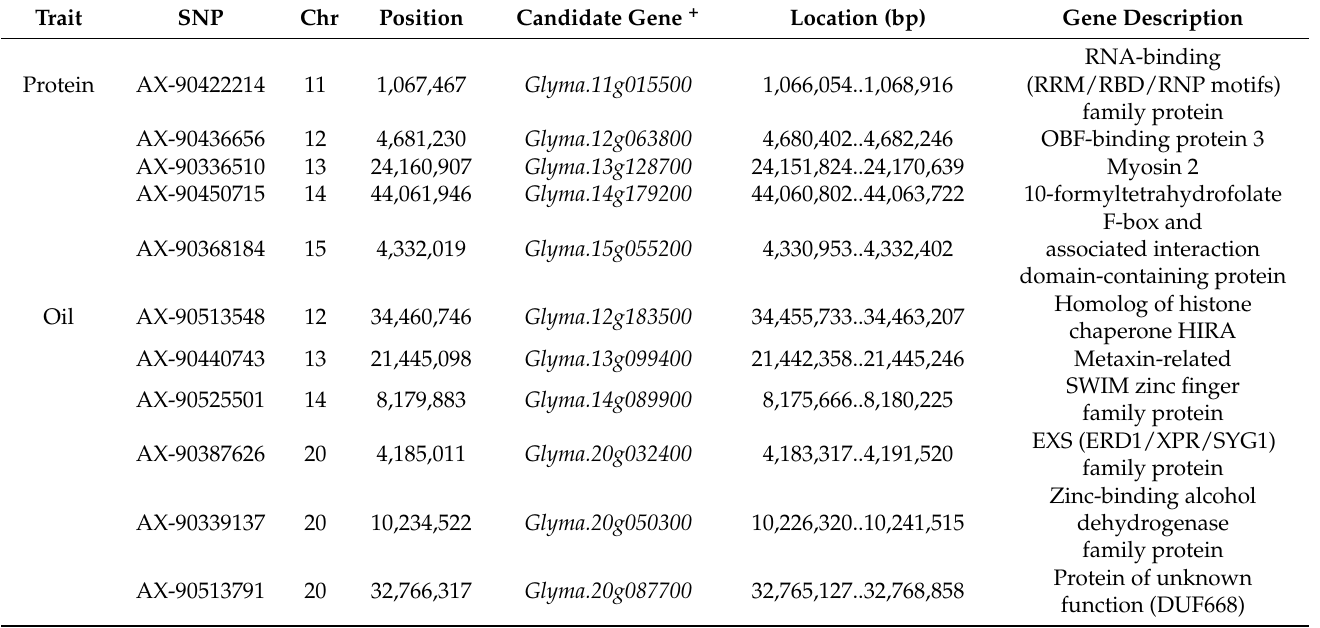
Table 5. Candidate genes associated with protein and oil content in wild soybean.